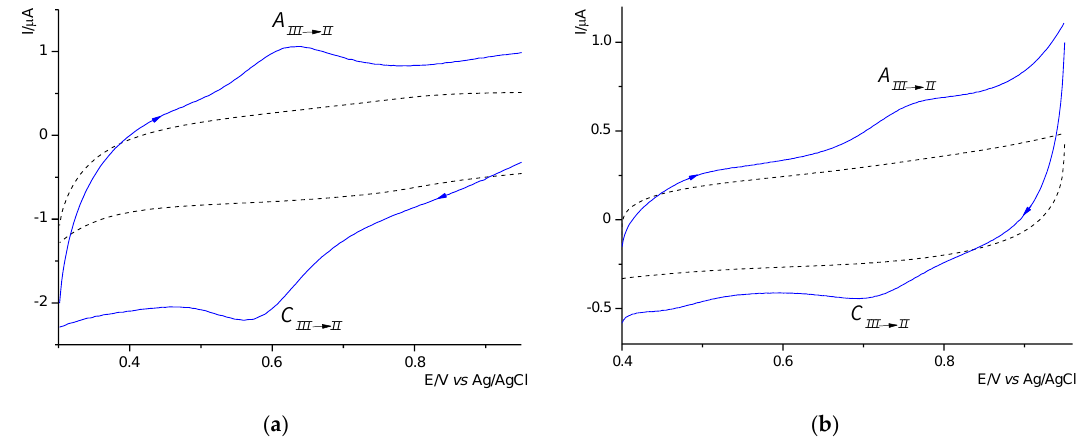
Figure 5. Cyclic voltammograms of complex 1 ( a ) and complex 2 ( b ) (each at a concentration of 1 mM) recorded in acetonitrile – ethanol mixture containing 0.1 M TBAPF 6 . Lines ( – ) and (---) represent the curves of the ruthenium complexes and the ligand/supporting electrolyte, respectively (CV conditions: GCE, Ø = 2 mm, T = 25 °C). Table 5. Electrochemical data [in V vs. Ag/AgCl] of the Ru(II) arene complexes obtained by CV. Complex